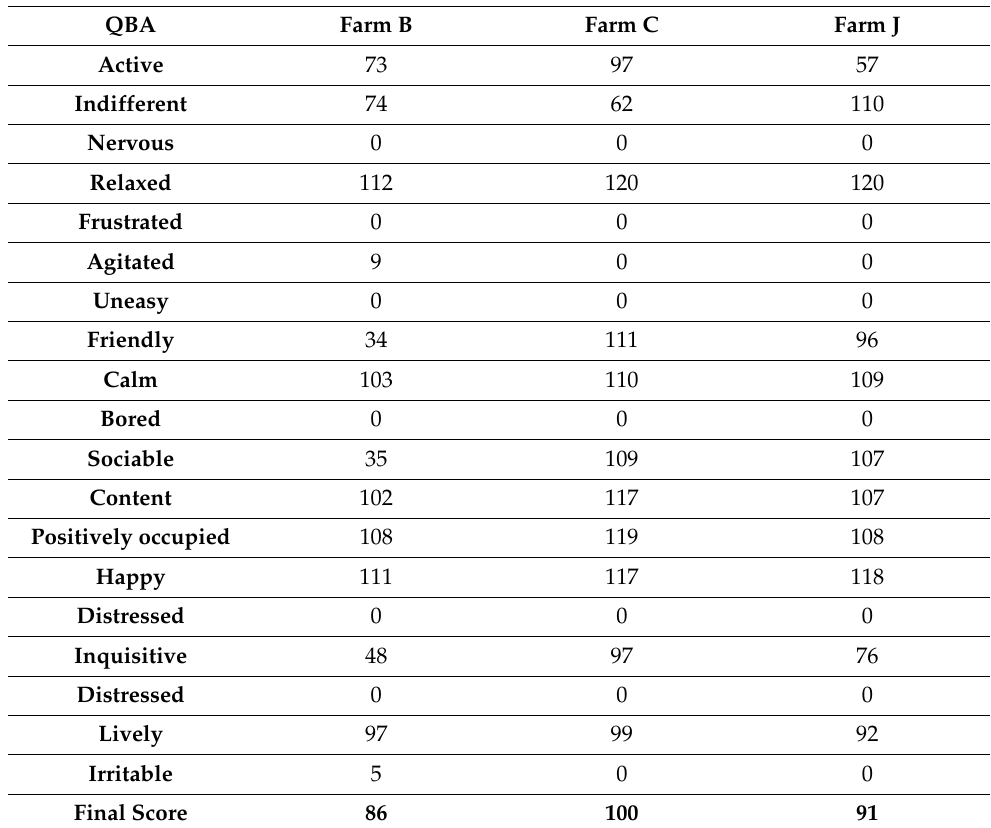
Table 2. Quality Behavior Assessment (QBA) on the three farms belonging to the study (values are in mm in a 125mm visual analogue